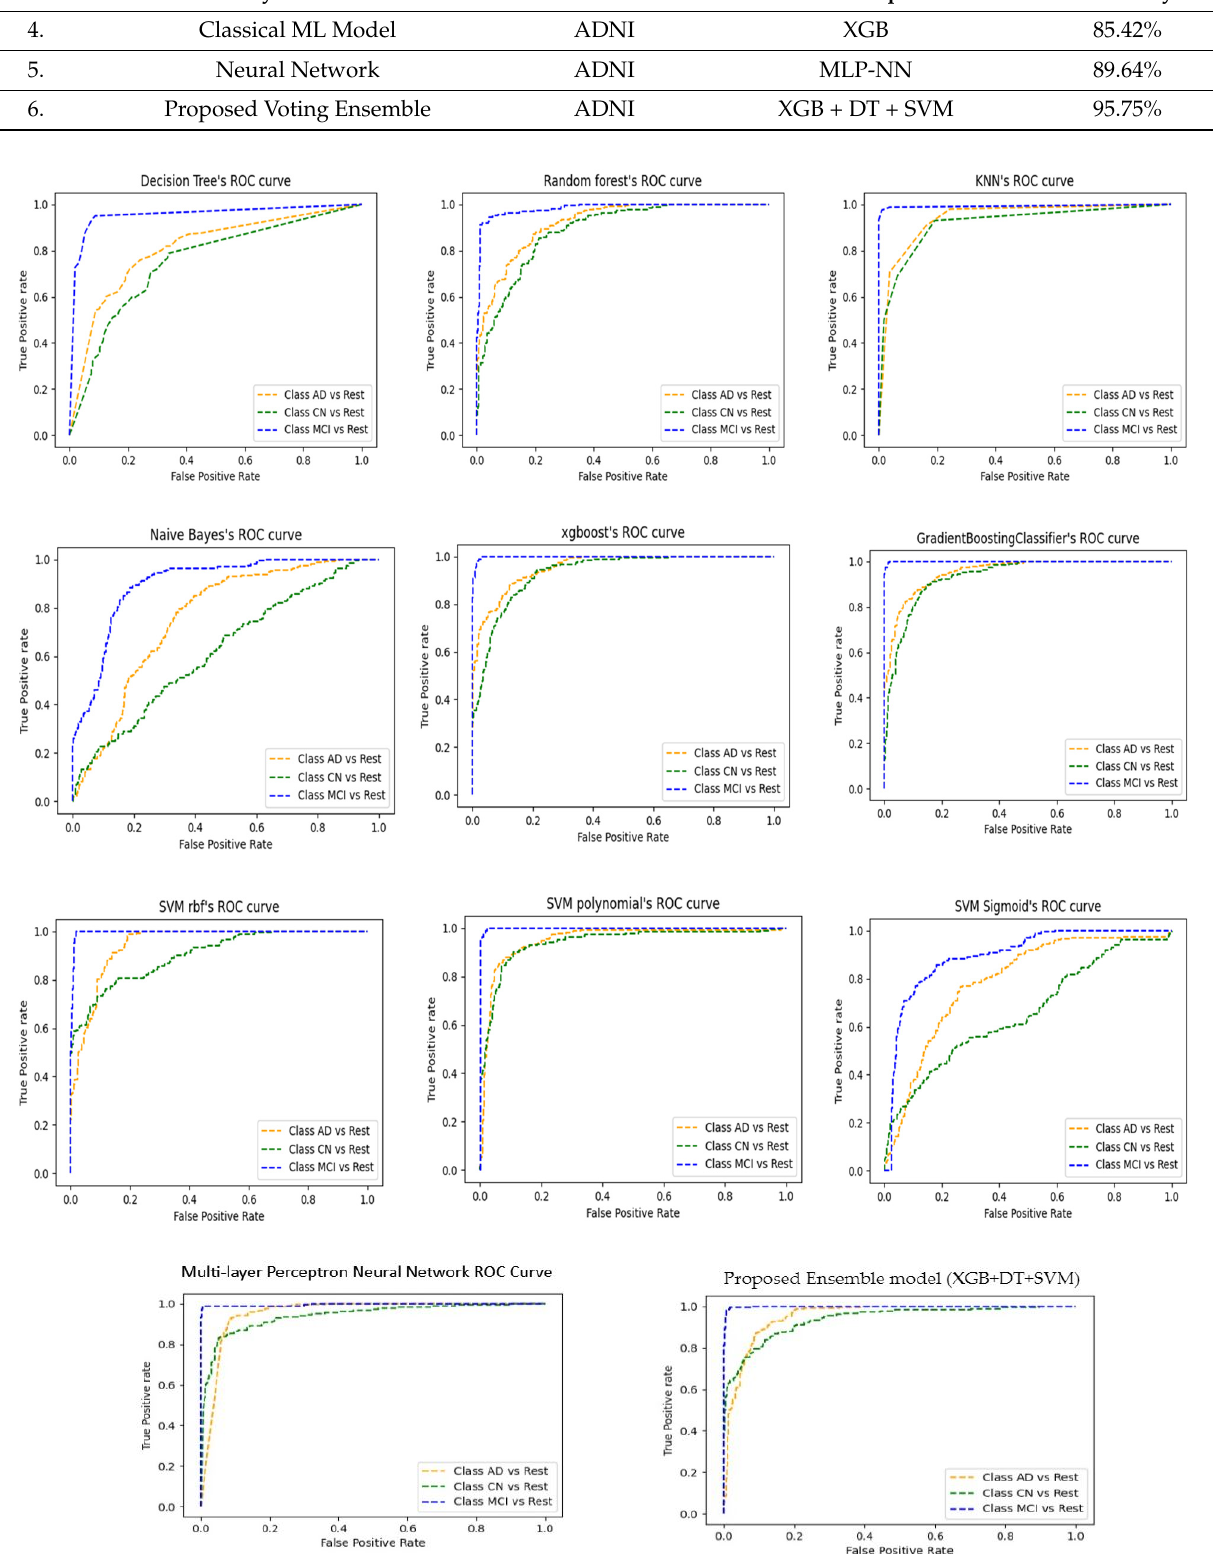
Figure 9. ROC plots for models to visualize the correct predicted and false predicted values for the classification of AD, CN and